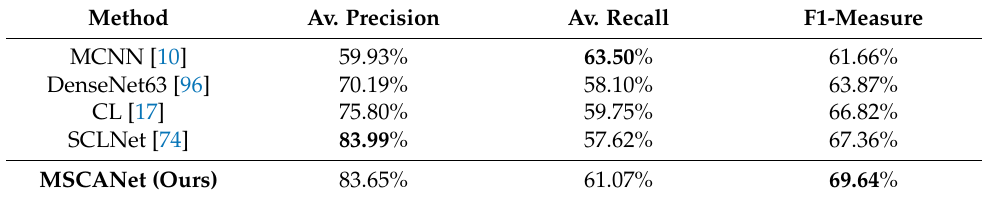
Figure 4. Visualizations of MSCANet for crowd localization on the UCF-QNRF dataset. Red points denote the ground-truth, and green points denote the estimated location results of MSCANet. Table 2. Comparison of the localization results on the UCF-QNRF